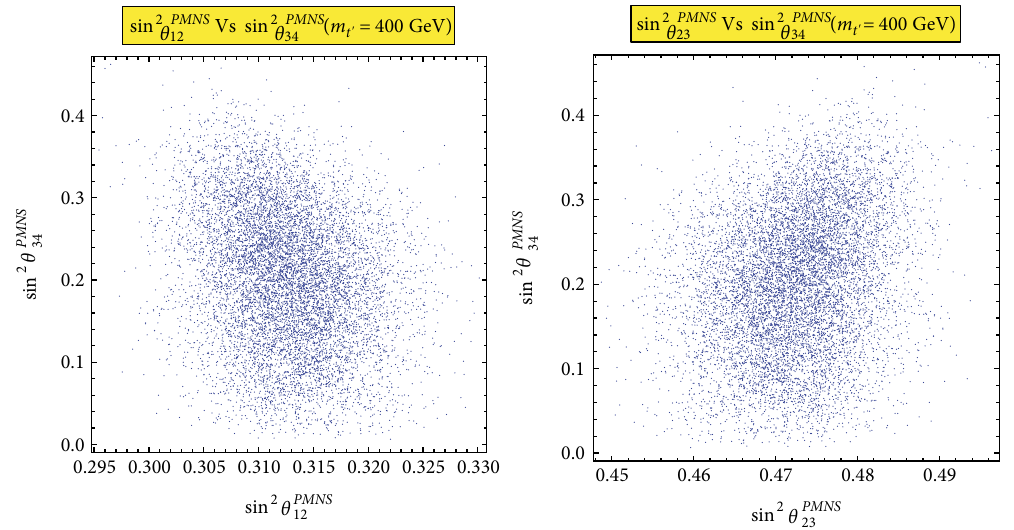
Figure 2: Correlation plot for sin 2 𝜃 𝑃𝑀𝑁𝑆